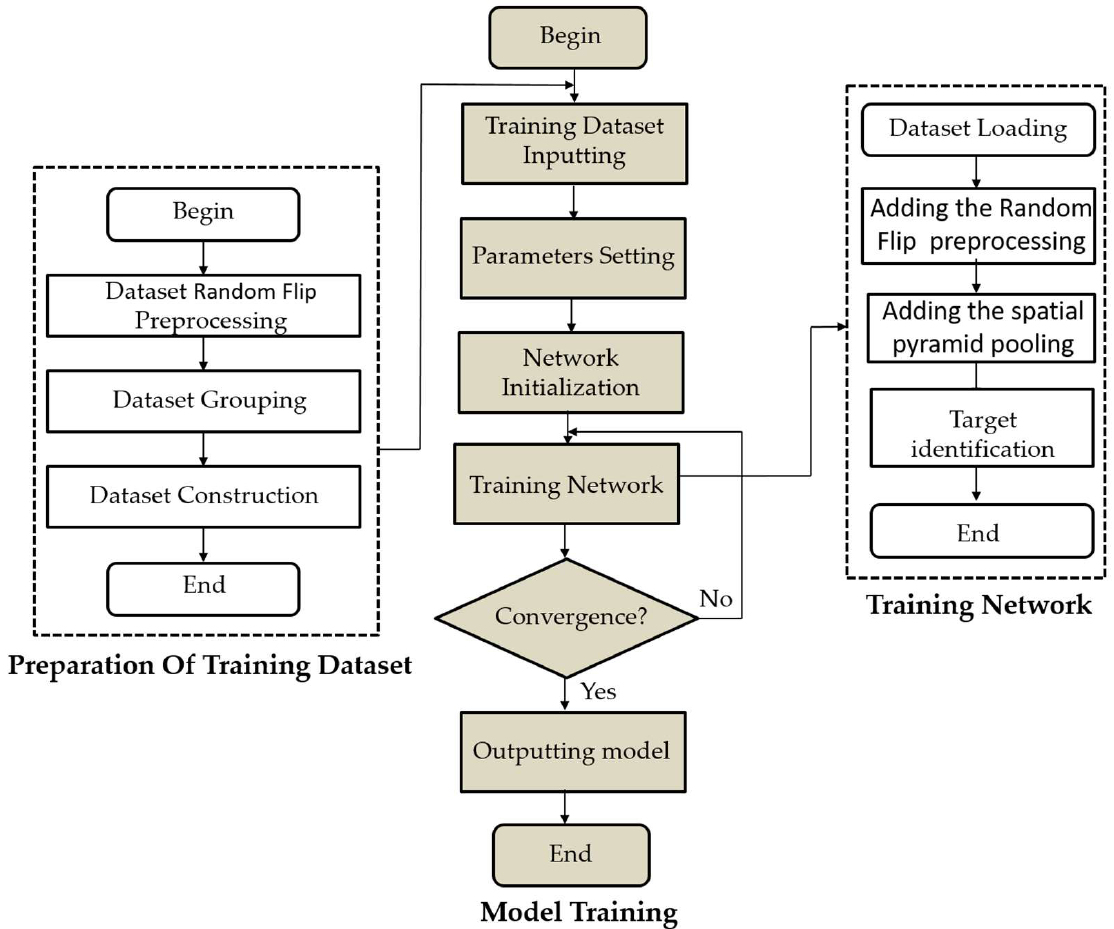
Figure 9. Flow chart of the target detection processes.